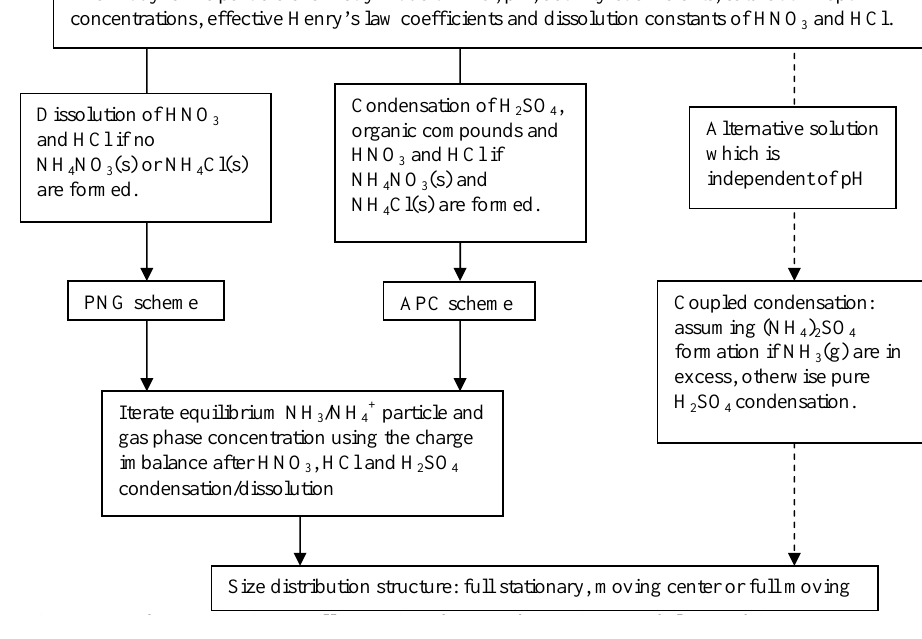
Figure 2. Schematic picture illustrating the condensation module used in ADCHEM. 2 Fig. 2. Schematic picture illustrating the condensation module used in